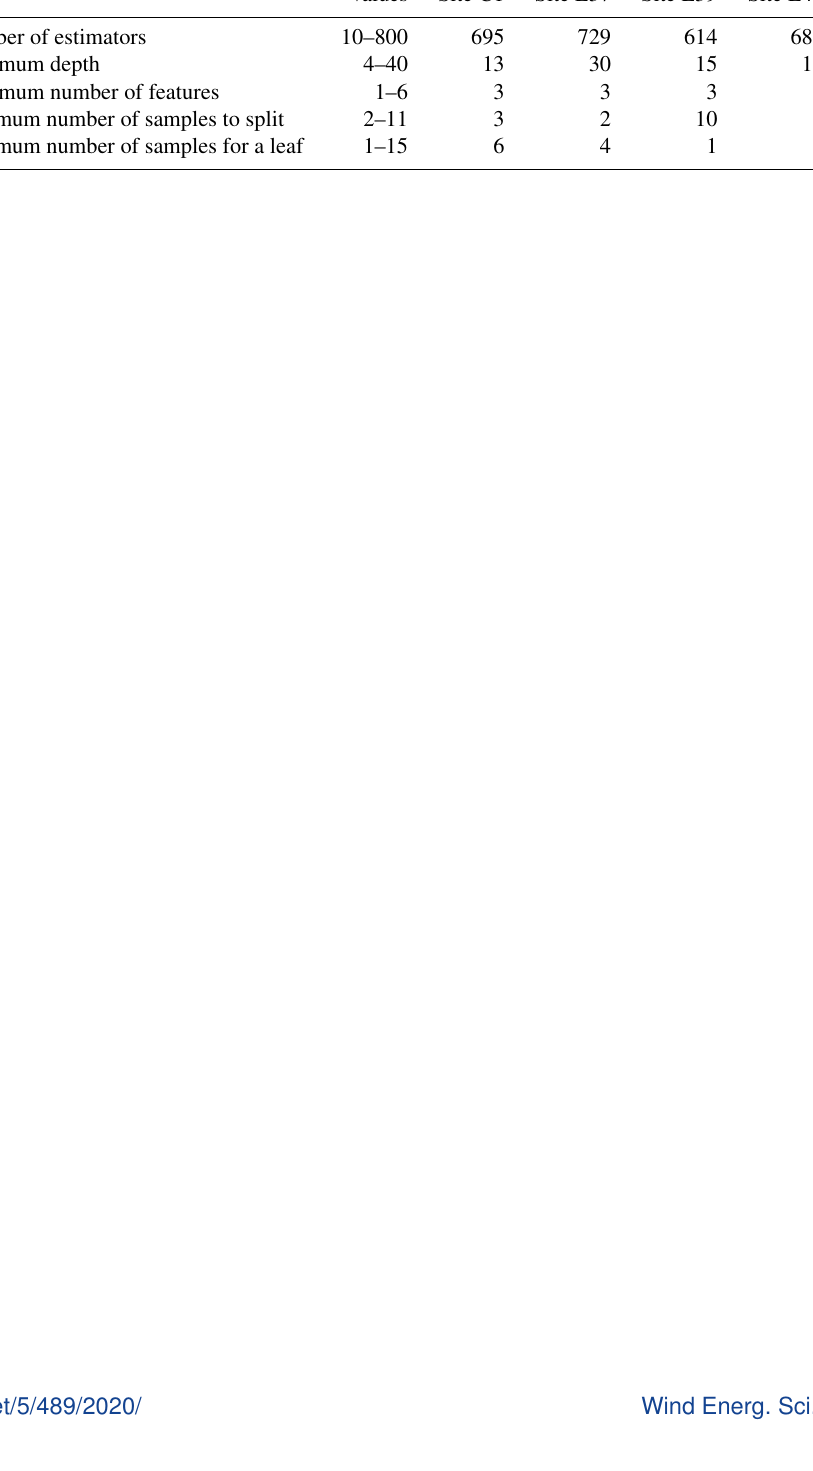
Table A1. Algorithm hyperparameters considered for the random forest and their selected values for each site as a result of cross validation. Possible Chosen value Hyperparameter